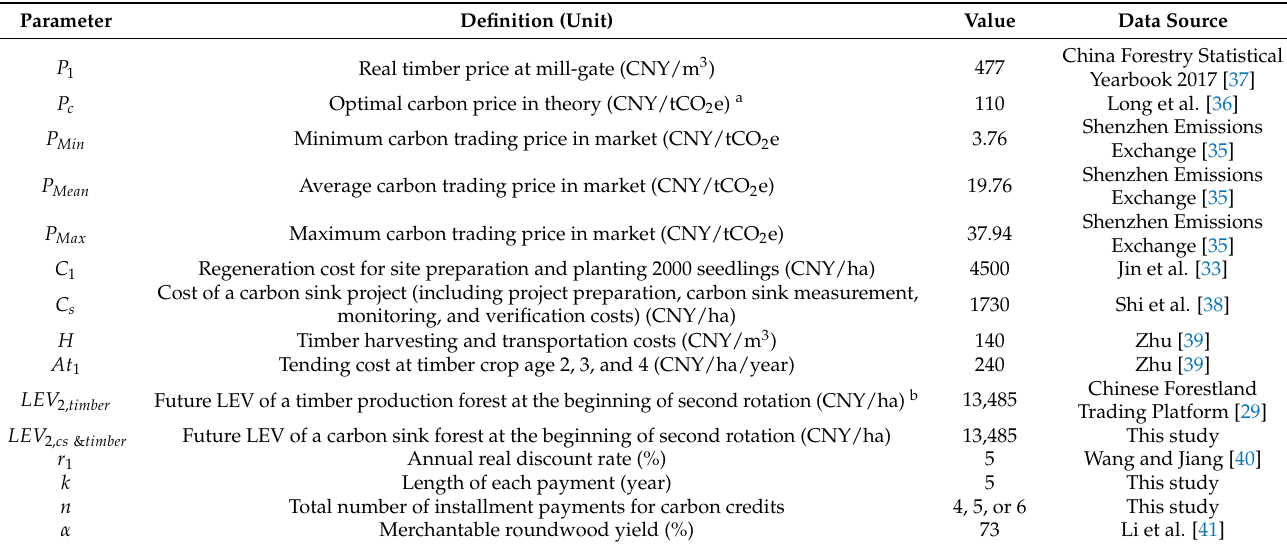
Table 1. Economic parameters and values used in the generalized Faustmann